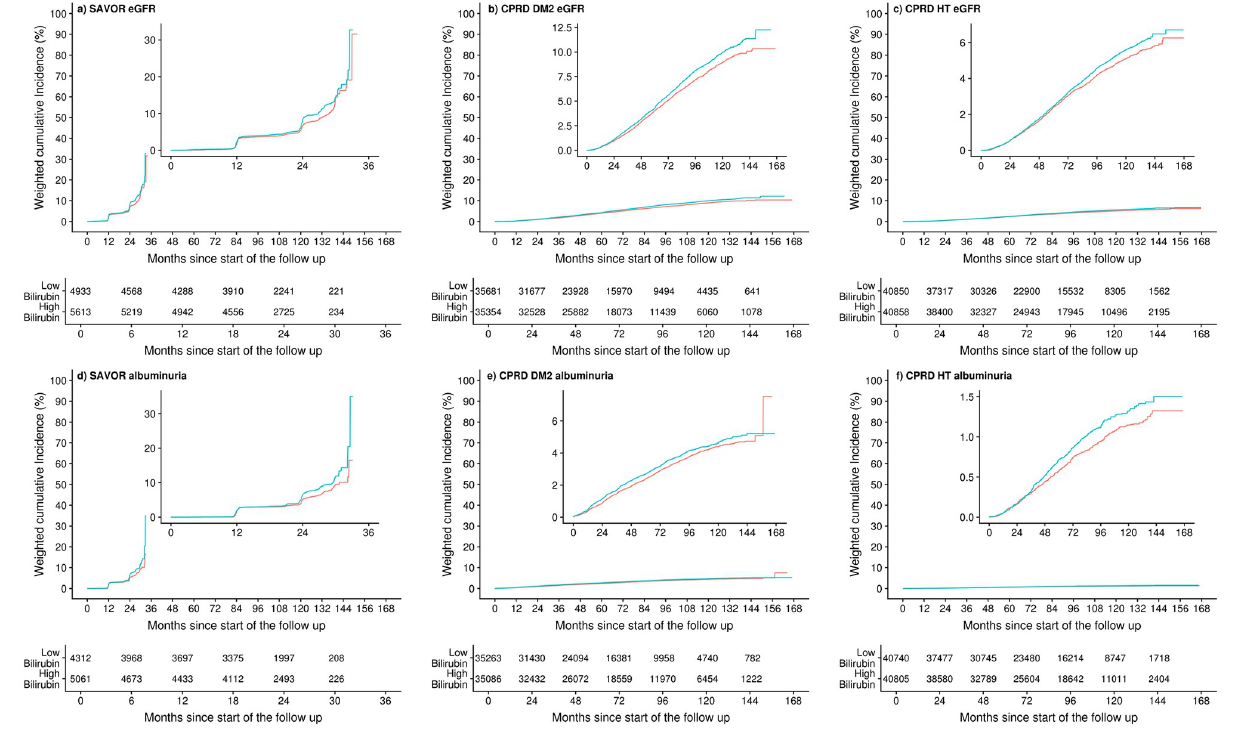
Fig 6. Weighted cumulative incidence plots of the primary and secondary end points. The primary endpoint of the study was estimated glomerular filtration rate (estimated by the CKD EPI formula) of more than 30% from the baseline (Panels a, b, c). The secondary endpoint of the study was the first observation of the albumiunria (defined by the urine albumin creatinine ratio greater or equal to 30mg/mmol) (Panels d, e, f). The study cohorts are SAVOR (Panels a, d), CPRD-DM2 (Panels b, e), CPRD- (Panels c, f). High bilirubin plotted in red are the patient subpopulation that has above or equal cohort median of the baseline serum bilirubin concentration (9 μ mol/L for SAVOR, 10 μ nil/L for CPRD-DM2 and HT), Low bilirubin plotted in blue are the patient subpopulation that has below cohort median of the baseline serum bilirubin concentration, The cumulative incidences were estimated with the use of the Kaplan–Meier method where the events are weighted by the inverse probability weighting scheme with the propensity score calculated based on the confounding covariates (age, sex, race if available, baseline body mass index, baseline hemoglobin, baseline alanine transaminase, baseline aspartate transaminase,